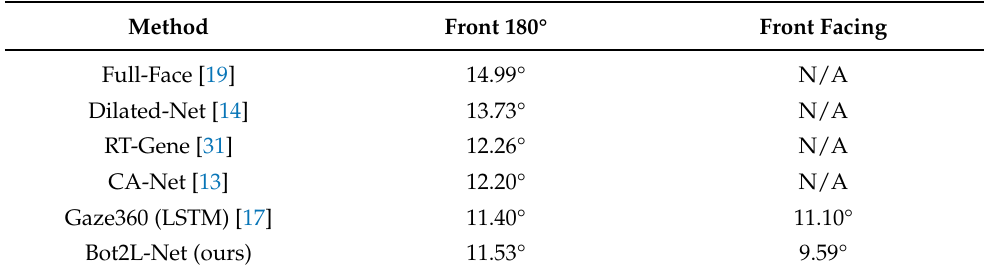
Figure 9. Mean Angular Error for subjects in the MPIIGaze testing set on BoT2L-Net, AGE-Net, and FAR-Net. Table 3. Comparison of mean angular error between our proposed model and state-of-the-art methods, on the MPIIGaze testing